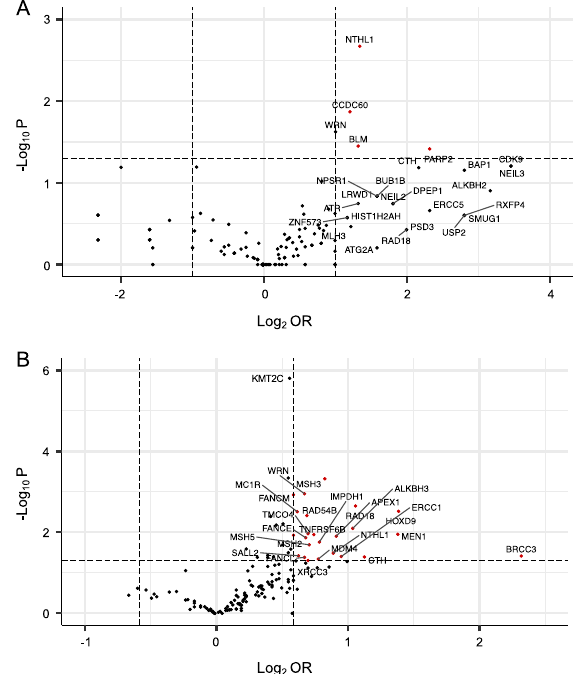
Fig. 3 Distribution of candidate genes by ORs and p -values for LoF and MS variants. Volcano plots of the distribution of candidate genes ( N = 145) by ORs and p -values in the LoF variant analysis ( A ) or the MS variant analysis ( B ). Genes are predominantly sequenced in a minimum of 4807 cases and 4782 controls with individual samples size listed in Supplementary Data. The horizontal axis is the log2(OR) and the vertical axis represents the reliability of the result ( − log10(P)). The horizontal dash line signals Fisher ’ s exact text P -value at 0.05. Two vertical dash lines show the thresholds of ORs (OR = 2 and = 0.50 for LoF variants and OR = 1.50 and = 0.67 for MS variants). Each dot represents a candidate gene and the red dots represent the genes that have a minimum fold excess of variants in the cases and have passed the p -value